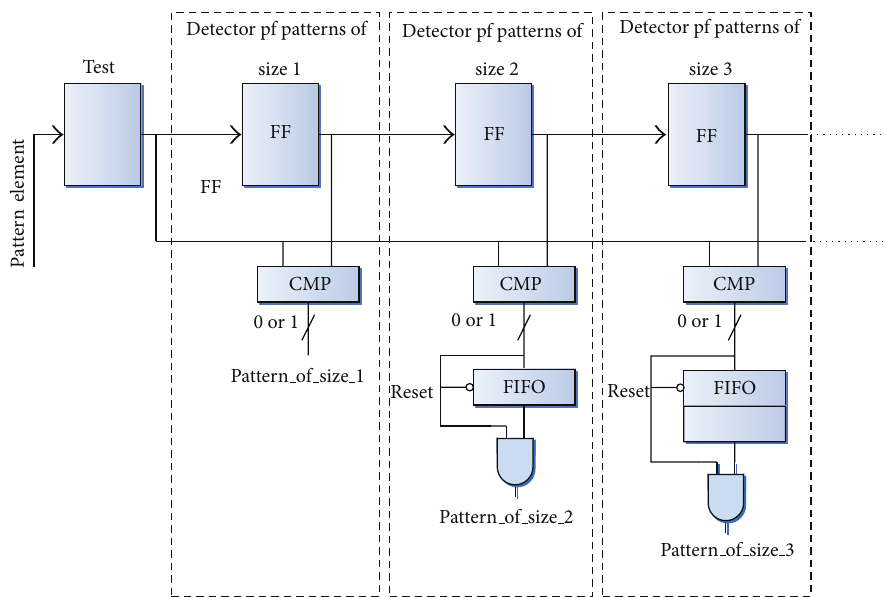
F 4: Diagram for a hardware implementation of the Squares Detector showing modules for pattern sizes from 1 to